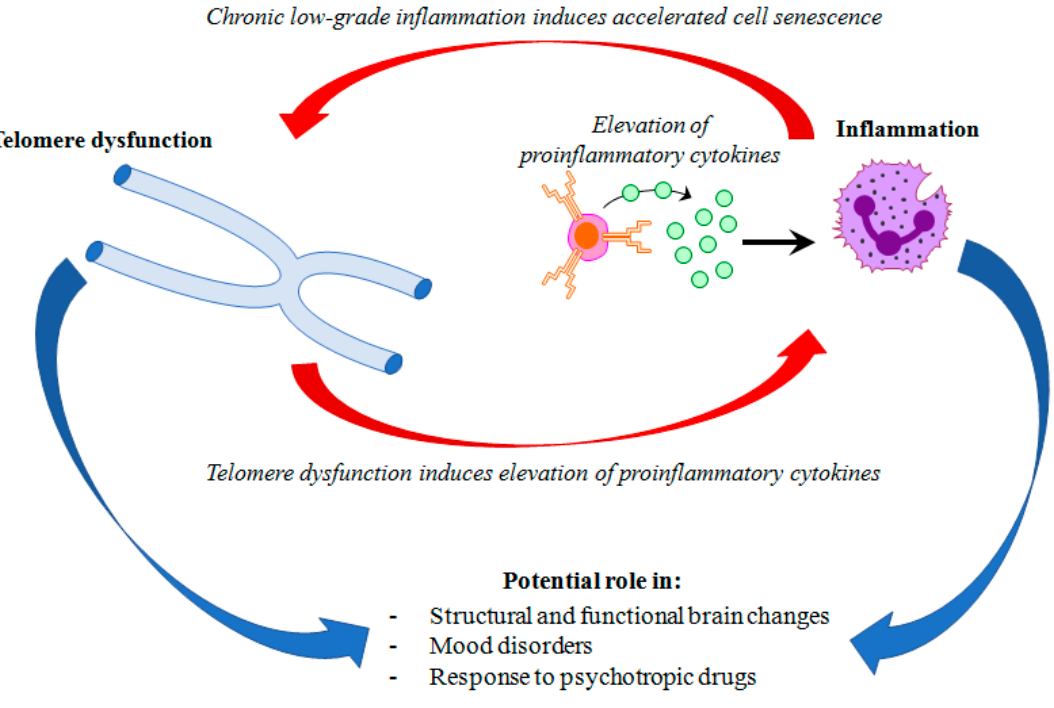
Figure 1. Hypothetical interplay between telomere dysfunction and low-grade inflammation in mood disorders.